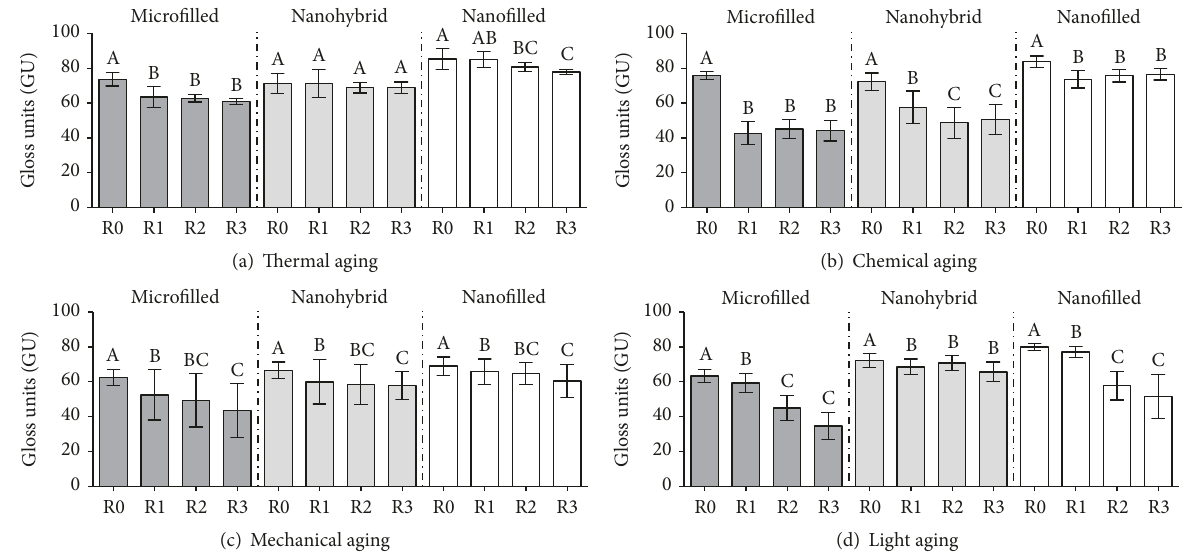
Figure 2: Comparison of surface gloss in relation to (a) thermal aging, (b) chemical aging, (c) mechanical aging, and (d) light aging. Different letters indicate statistical differences within each type of resin composite; 𝑝 < 0.05 .